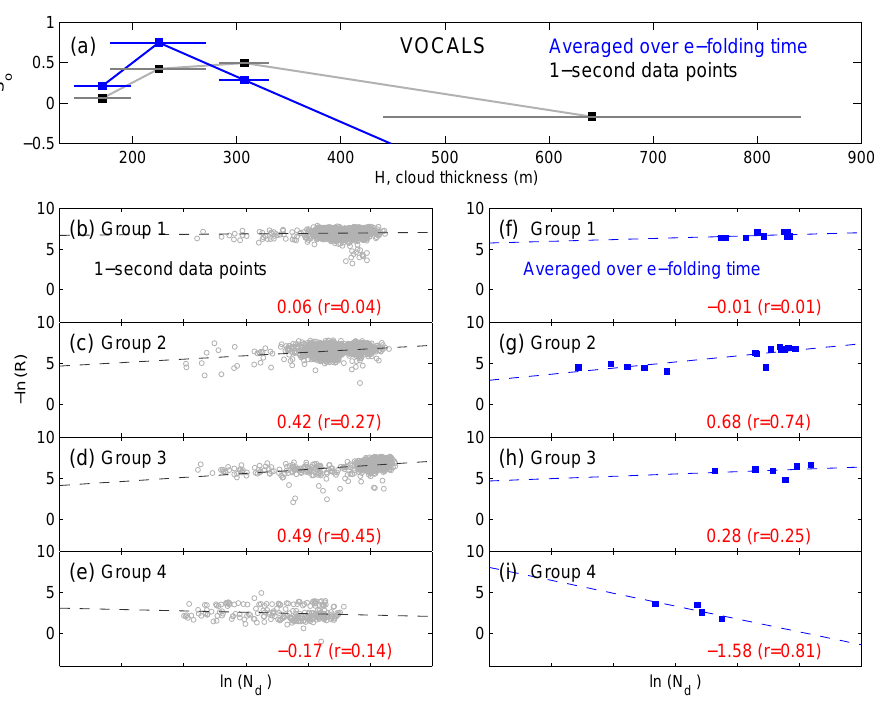
Figure 6. S o for VOCALS TO flight is calculated with 1s data (grey) and cloud data that are averaged over an e -folding time for each day (blue). The ln( N d ) and − ln( R ) diagram is shown for each H interval. The horizontal bar in (a) indicates ± 1 σ . S o is calculated for the cloud data in groups with similar H (shown in Table 1).